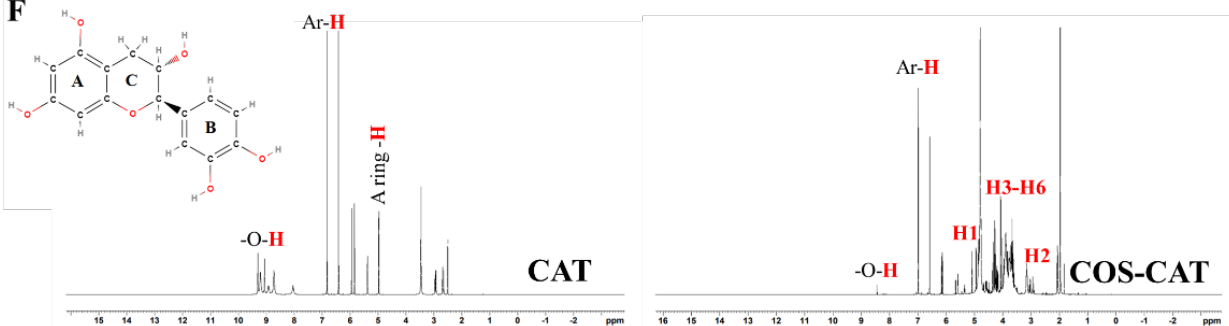
Figure 3. 1H-NMR spectra of COS ( A ), GAL and COS-GAL ( B ), FER and COS-FER ( C ), CAF and COS-CAF ( D ), EGCG and COS€CG ( E ), and CAT and COS-CAT ( F ): COS, chitooligosaccharide; GAL, gallic acid; FER, ferulic acid; CAF, caffeic acid; EGCG, epigallocatechin gallate; CAT, catechin. The 1 H-NMR spectrum of GAL showed -OH protons at 8.83 and 9.20 ppm and a car- boxyl group at 12.24 ppm (Figure 3B). The peak associated with the hydrogen atom of the aromatic ring appeared at 6.92 ppm [30]. As compared to COS, the COS-GAL conjugate showed a new peak related to phenyl protons of GAL at 6.9 ppm (Figure 3B).